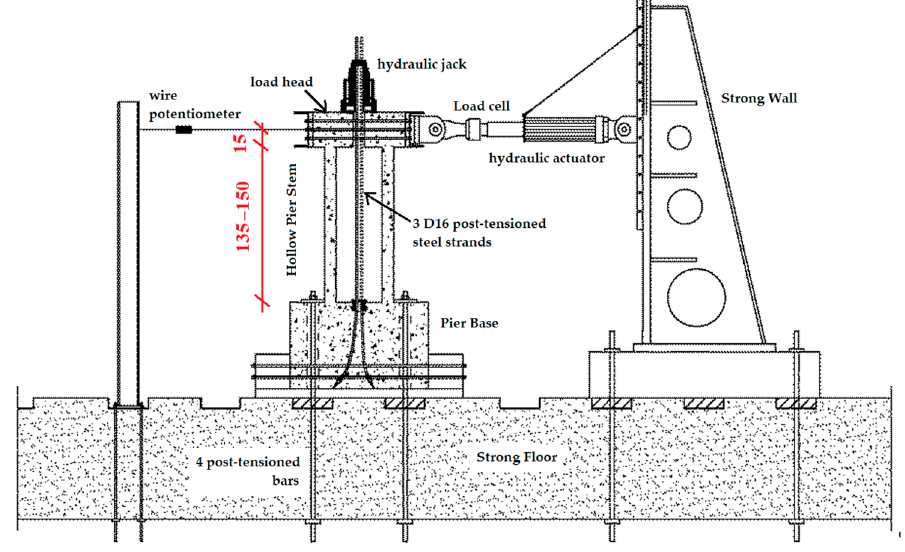
Figure 5. Cyclic load test setup scheme (dimensions in cm).